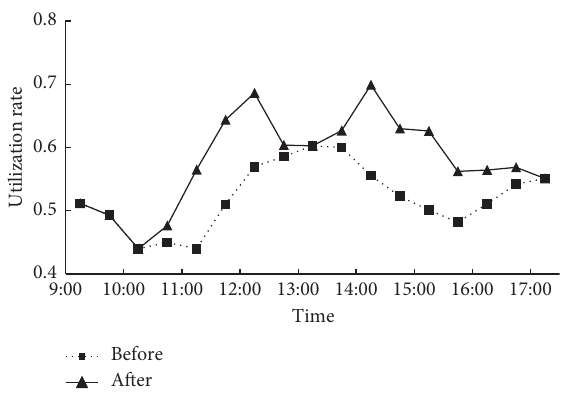
Figure 9: Total walking distance after parking from Song Lei Commercial Building to Peace Community.